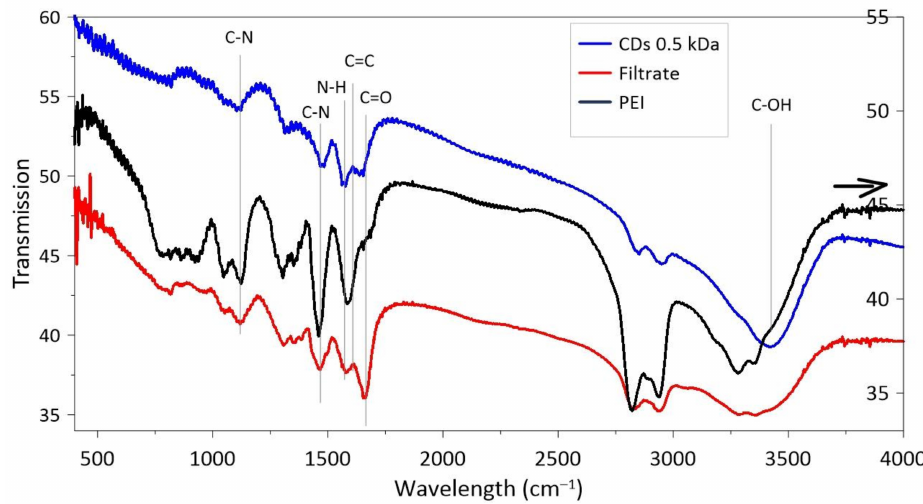
Figure 2. Fourier transform infrared (FTIR) spectra of nanostructures synthesized in PEI. The black arrow indicates the scale for